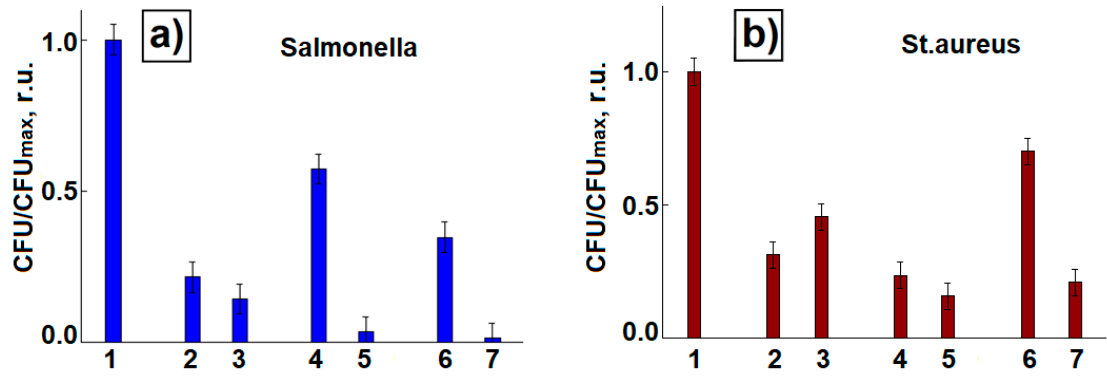
Figure 6. Biocidal activity of polymer coatings and nanocomposite coatings towards Salmonella ( a ) and St. Aureus ( b ): control (1); PEI (2); PEI/Ag (3); PAA/PEI 1/3 (4); PAA/PEI 1/3 + Ag (5); PAA/PEI 3/1 (6); PAA/PEI 3/1 +Ag (7).